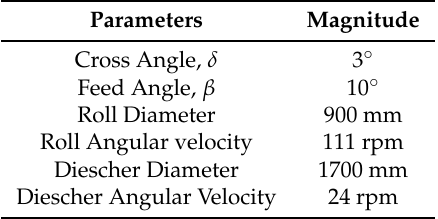
Table 1. Parameters of the rotary piercing mill FE model.